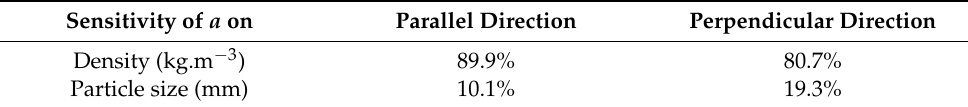
Table 5. Sensitivity coefficients for thermal diffusivity for both directions. Sensitivity of a